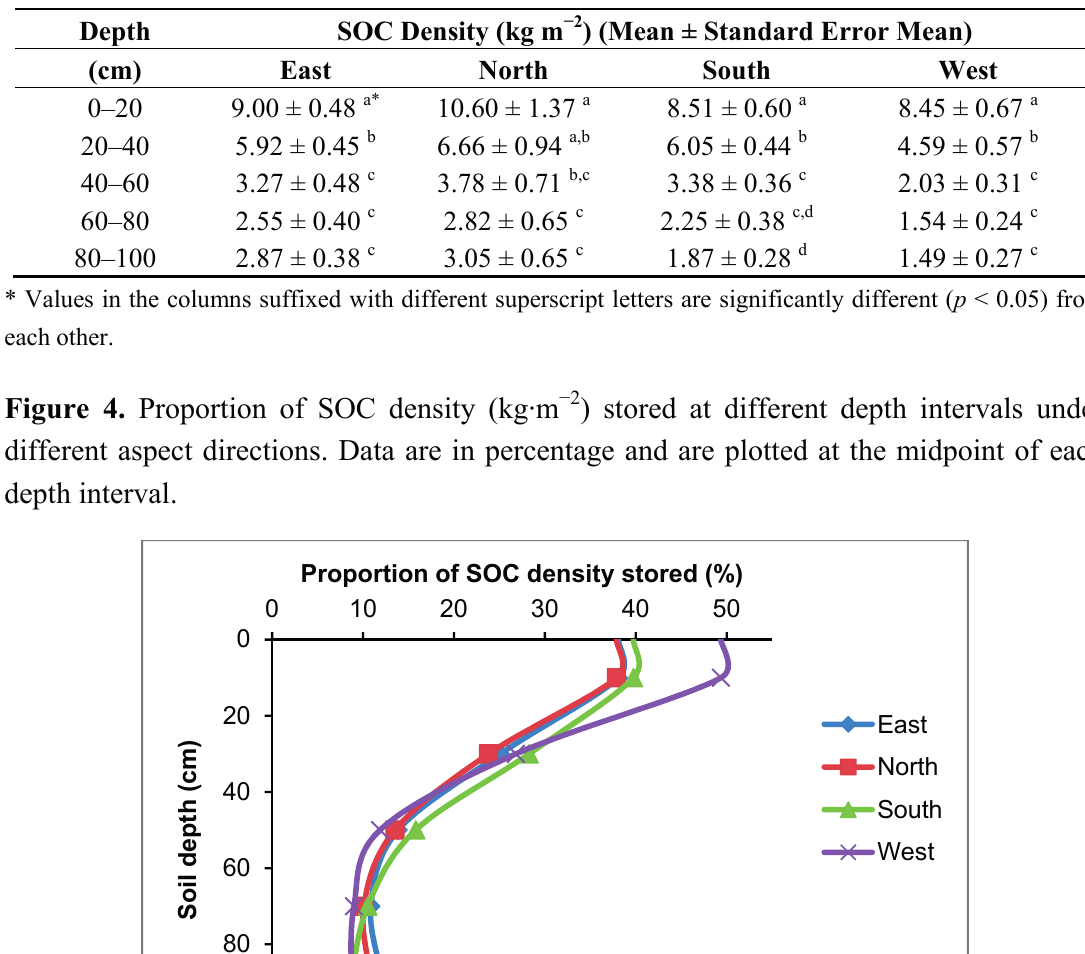
Table 7. Vertical distribution of mean SOC density values under different aspect directions.